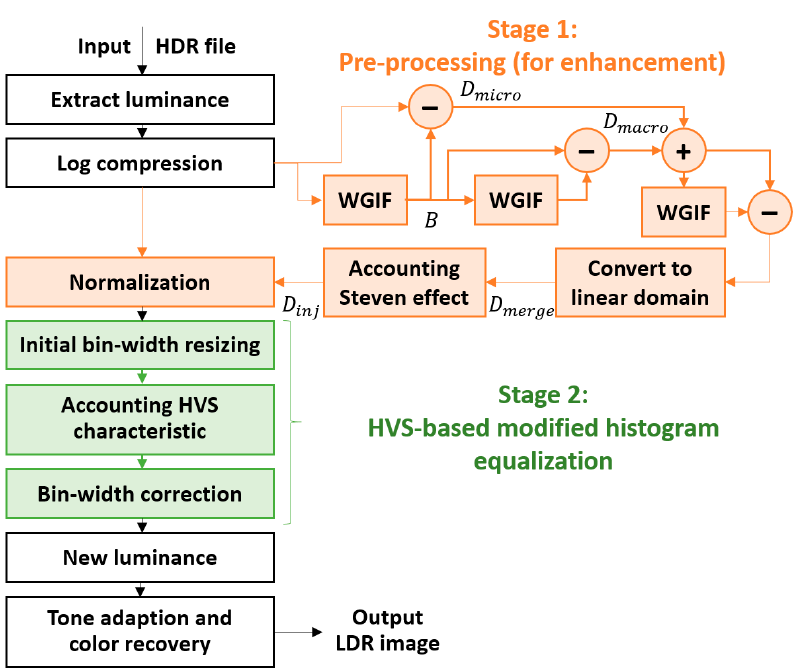
Figure 2. The overall framework of the proposed cascaded-architecture-type reproduction method, where WGIF indicates the weighted guided image filtering technique [24]. In this paper, two stages were designed to complement each other to achieve the advantages of both the local and the global operators.